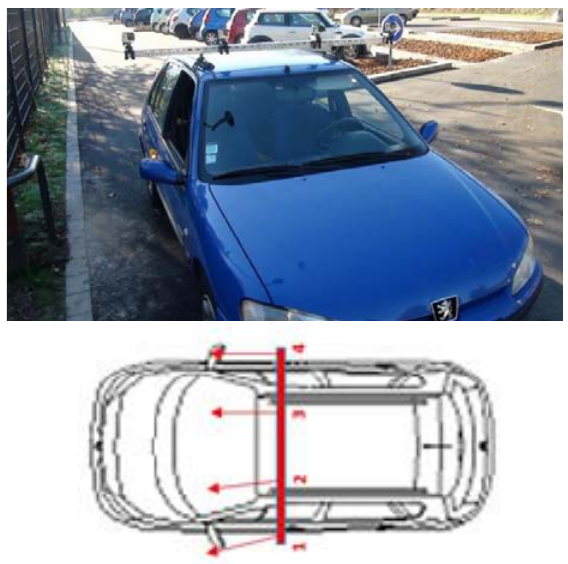
Fig. 5: Acquisition device mounted on a roof bar